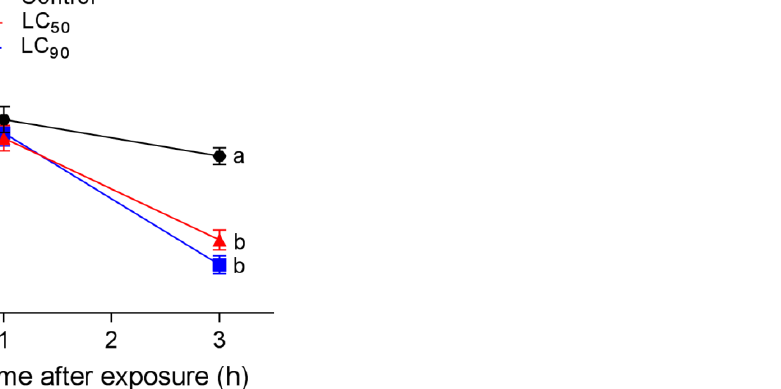
Figure 3. Respiration rate of Spodoptera frugiperda caterpillars exposed to deltamethrin (control, LC 50 , and LC 90 estimated values) for 3 h. Treatments (mean ± SEM) differ at p < 0.05 (Tukey’s mean separation test).